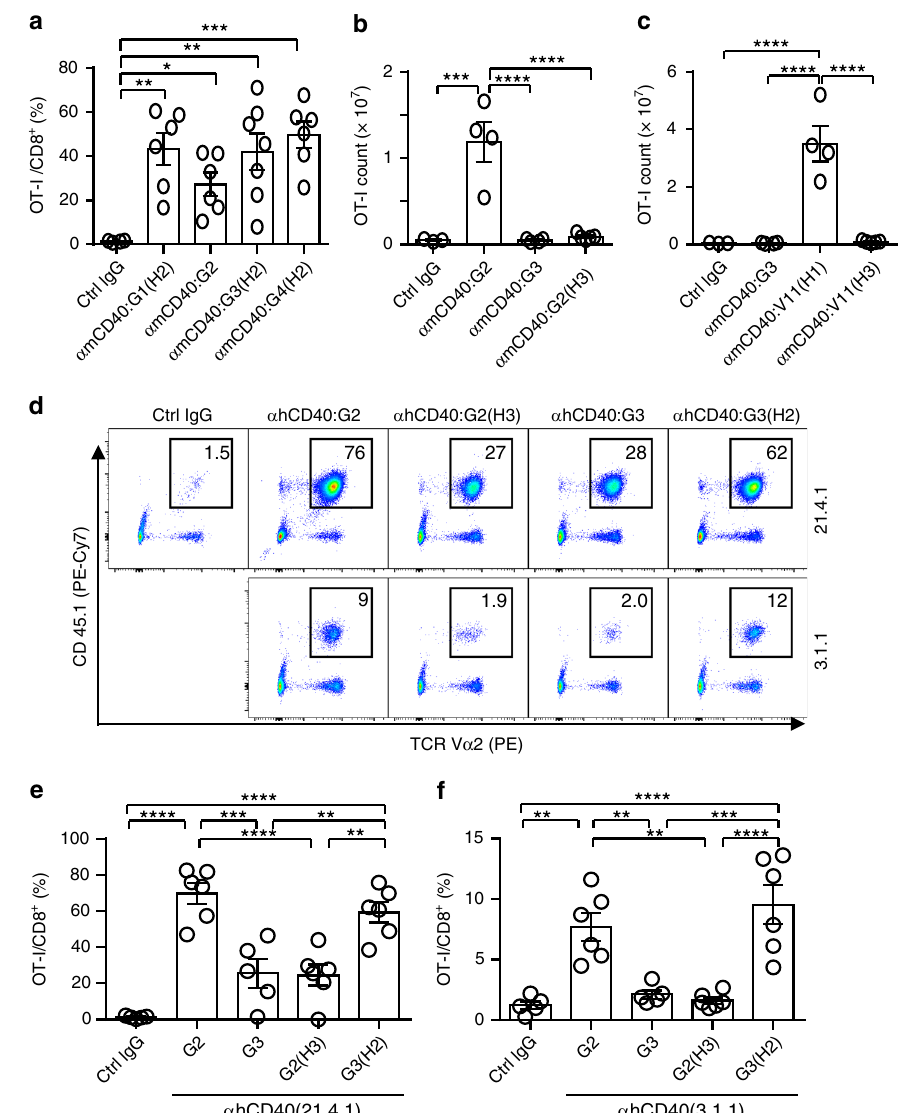
Fig. 2 CH1-hinge basis of agonistically inactive IgG3 and superior IgG2. a – c Quanti fi cation of OT-I cells as the percentage of OT-I cells among CD8 + T